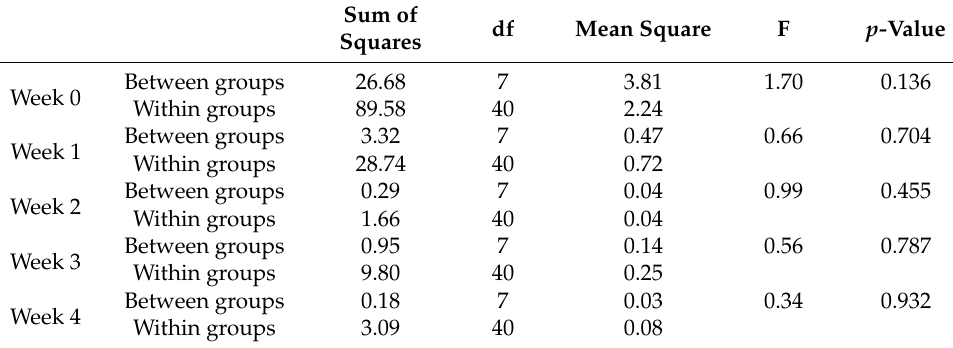
Table 3. MEP comparison using one-way ANOVA with time factor ( n = 24).